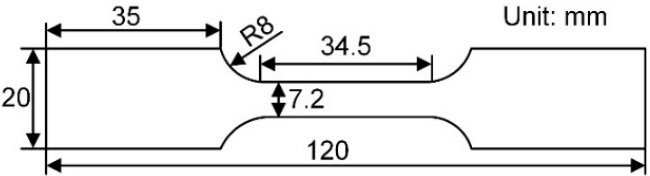
Figure 2. Schematic diagram of tensile samples.